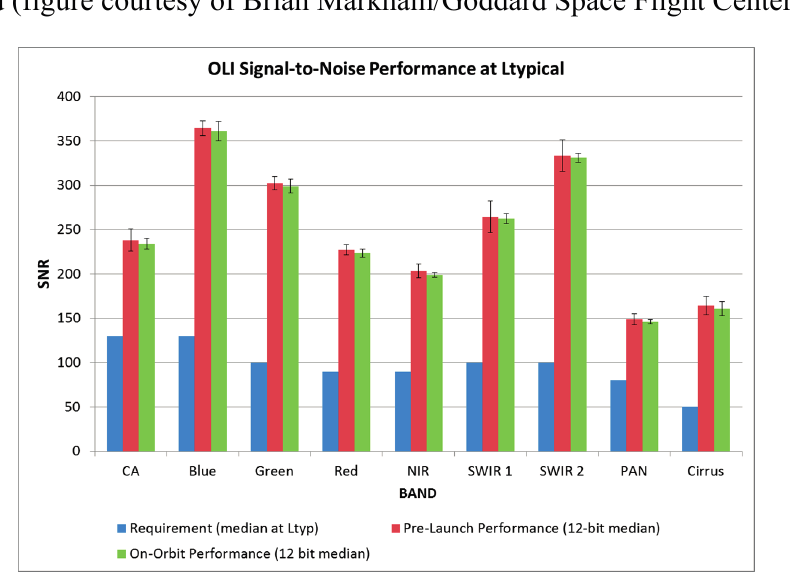
Figure 21. The signal-to-noise ratio exceeded the requirements even when uncertainties were included (figure courtesy of Brian Markham/Goddard Space Flight Center